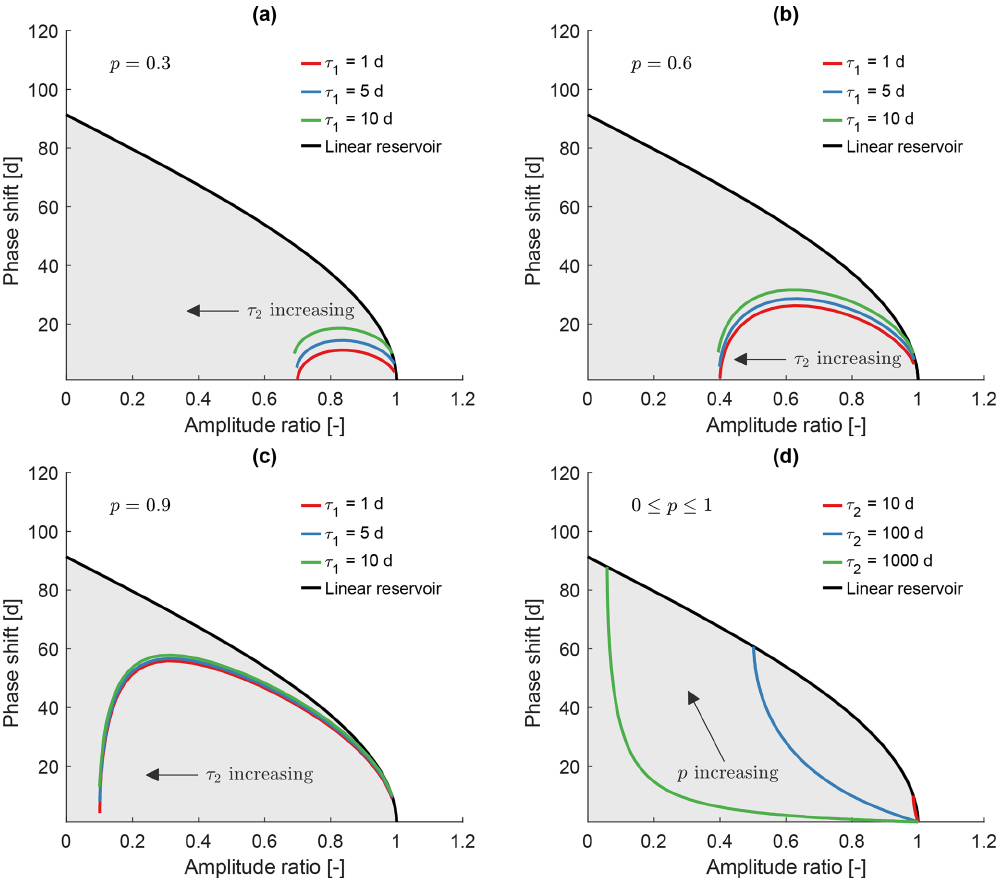
Figure 3. Amplitude ratio against phase shift for two linear reservoirs in parallel. (a) Each line has a fixed time constant for the first reservoir ( τ 1 ), while the time constant of the second reservoir varies (10d ≤ τ 2 ≤ 10000d; it is increasing from right to left). The fraction p going into the second reservoir is 0.3. (b) Same as (a) with p = 0 . 6. (c) Same as (a) with p = 0 . 9. (d) Each line has a fixed time constant for the first reservoir ( τ 1 = 1d) and for the second reservoir ( τ 2 ). The fraction p going into the second reservoir is varied (it is increasing from right to left). The shaded area contains all the possible combinations of amplitude ratio and phase shift for two linear reservoirs in parallel.